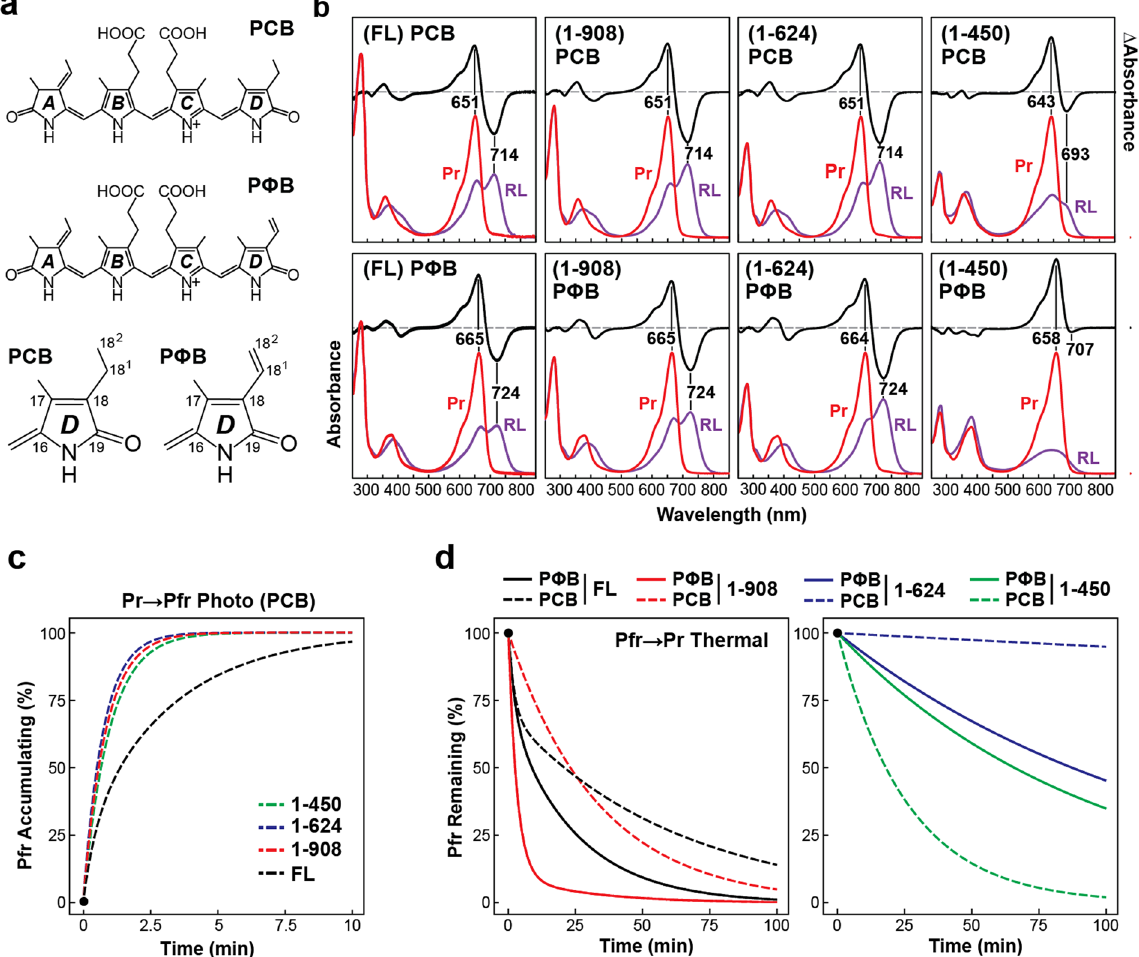
Figure 5. Substitution of P Φ B with PCB dramatically alters the spectral properties of PhyB and thermal reversion of Pfr. (a) Chemical diagrams of P Φ B and PCB. Differences in the D pyrrole rings are highlighted below. (b) UV-Vis absorption and difference spectra for full-length (FL) PhyB and various C-terminal truncation mutants after dark-adaption (Pr) or following saturating red-light irradiation (RL). To attain saturation of the Pfr state, the FL P Φ B-containing species was irradiated with 660-nm light at 1250 μ mol ⋅ m − 2 ⋅ s − 1 , whereas all other species were irradiated with 630-nm light at 230 μ mol ⋅ m − 2 ⋅ s − 1 . Composition of the C-terminal truncations assembled with P Φ B are described in Fig. 1a. Absorption maxima and minima are indicated. Bilin occupancies of the PCB- and P Φ B-containing preparations are shown in Supplementary Fig. S4. (c) Pr → Pfr photoconversion of PCB-bound chromoproteins. (d) Thermal reversion rates for samples described in panel (b) upon assembly with PCB (dashed lines) or P Φ B (solid lines). Kinetic traces were calculated from rate constants listed in Table